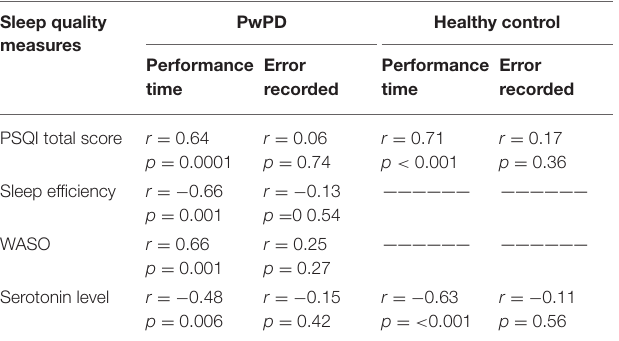
TABLE 4 | Partial correlation in healthy controls between motor skill acquisition outcomes and sleep quality measures and plasma levels of serotonin controlling cognitive status and depression level.